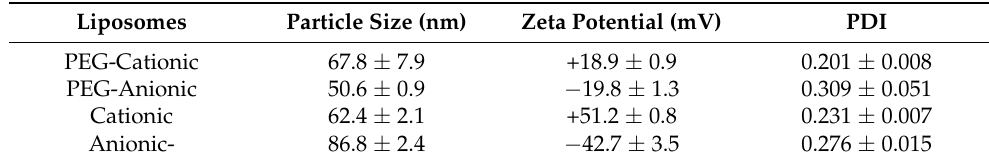
Table 2. Physical properties of various liposomes.